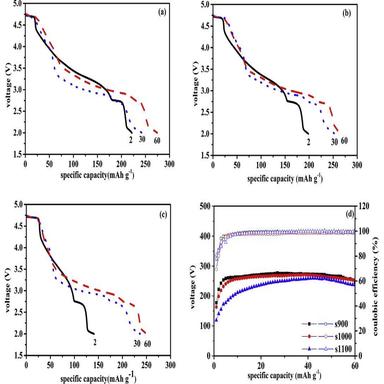
Discharge profiles of (a) s900, (b) s1000, and (c) s1100 at the different cycles at 0.1C rate over a 2.0e4.8 V voltage window. (d) Cycling stability curves of the s900, s1000, and s1100 samples at 0.1C rate.